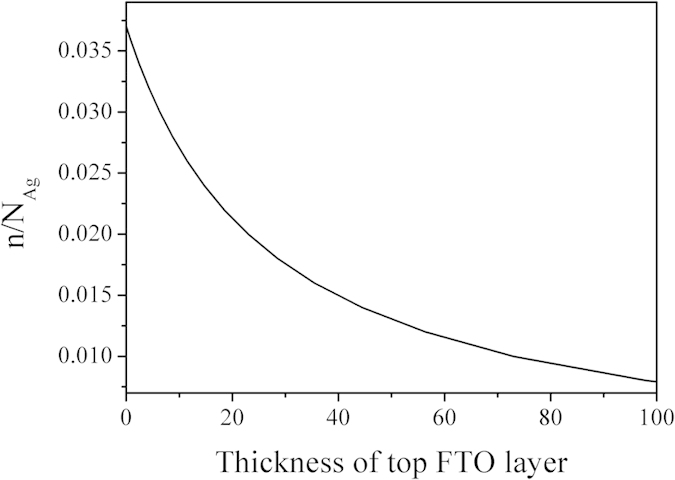
The thickness of top FTO layer versus n/NAg.